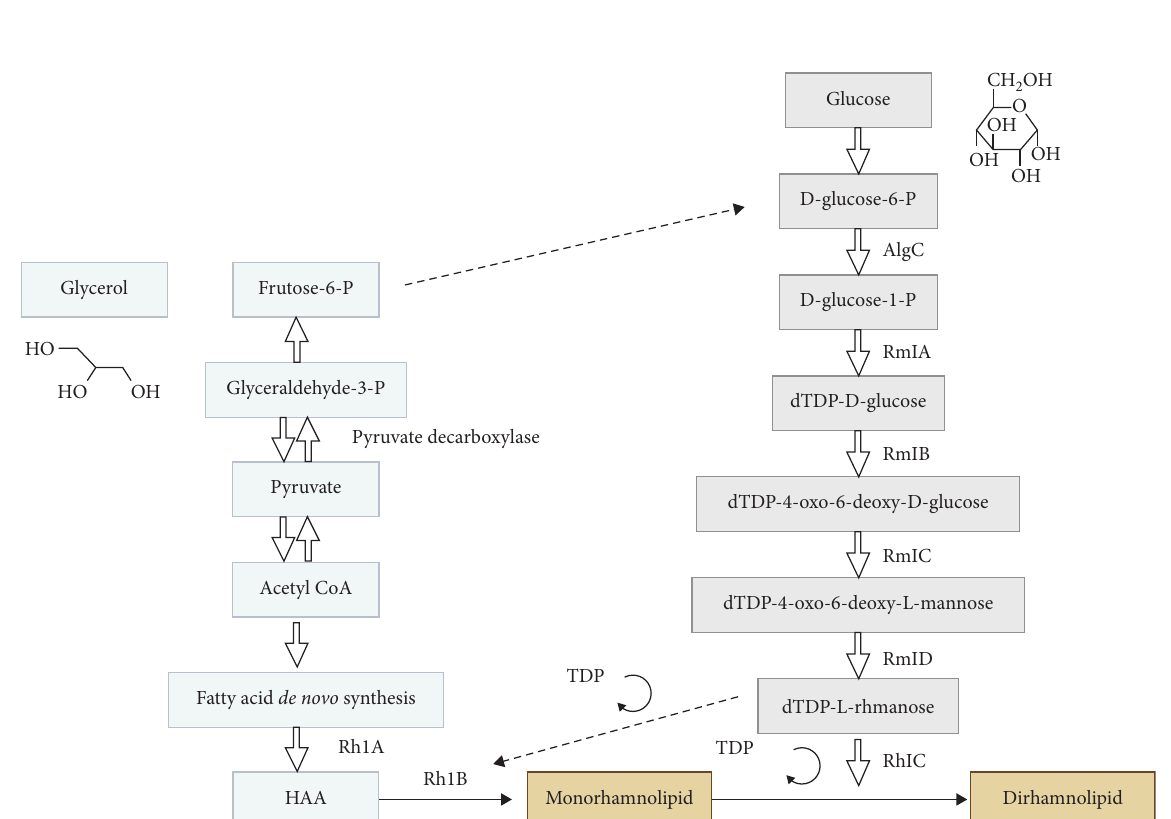
Figure 4: Biosynthesis related to the production of biosurfactants or bioemulsifiers using hydrophilic and hydrophobic sources as substrates [30]. ∗ Image was created using Biorender.